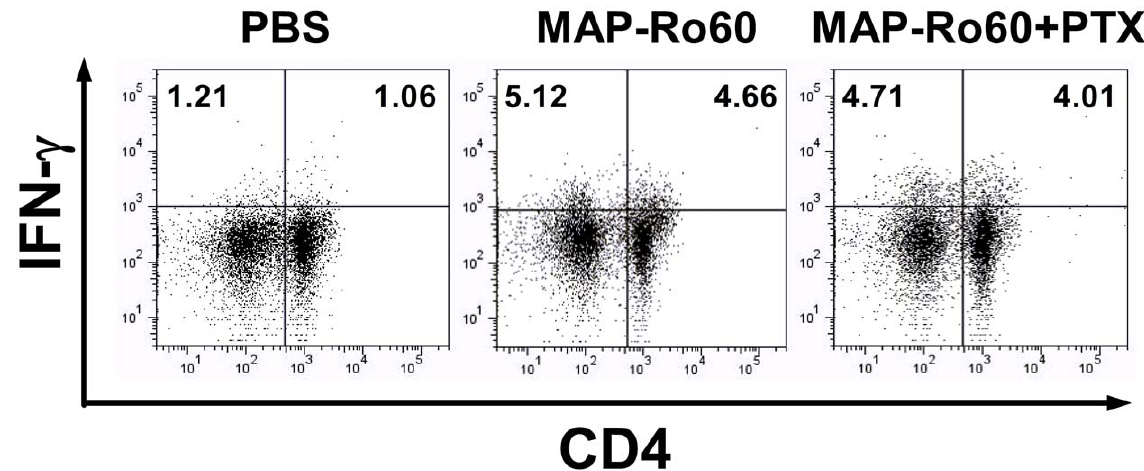
Figure 5. Increased IFN- c releasing lymphocytes in salivary gland associated lymph nodes from SJL/J mice. The SG lymph nodes cells isolated from mice immunized with PBS (mock) or MAP-Ro60 + /- PTX were analyzed by flow cytometry assay for IFN- c + and specifically CD4 + IFN- c + (Th1) lymphocyte induction 10 days post primary immunization. The SG lymph node cells from one group (N=10) are pooled and divided into 2 samples. Data shown is from one representative